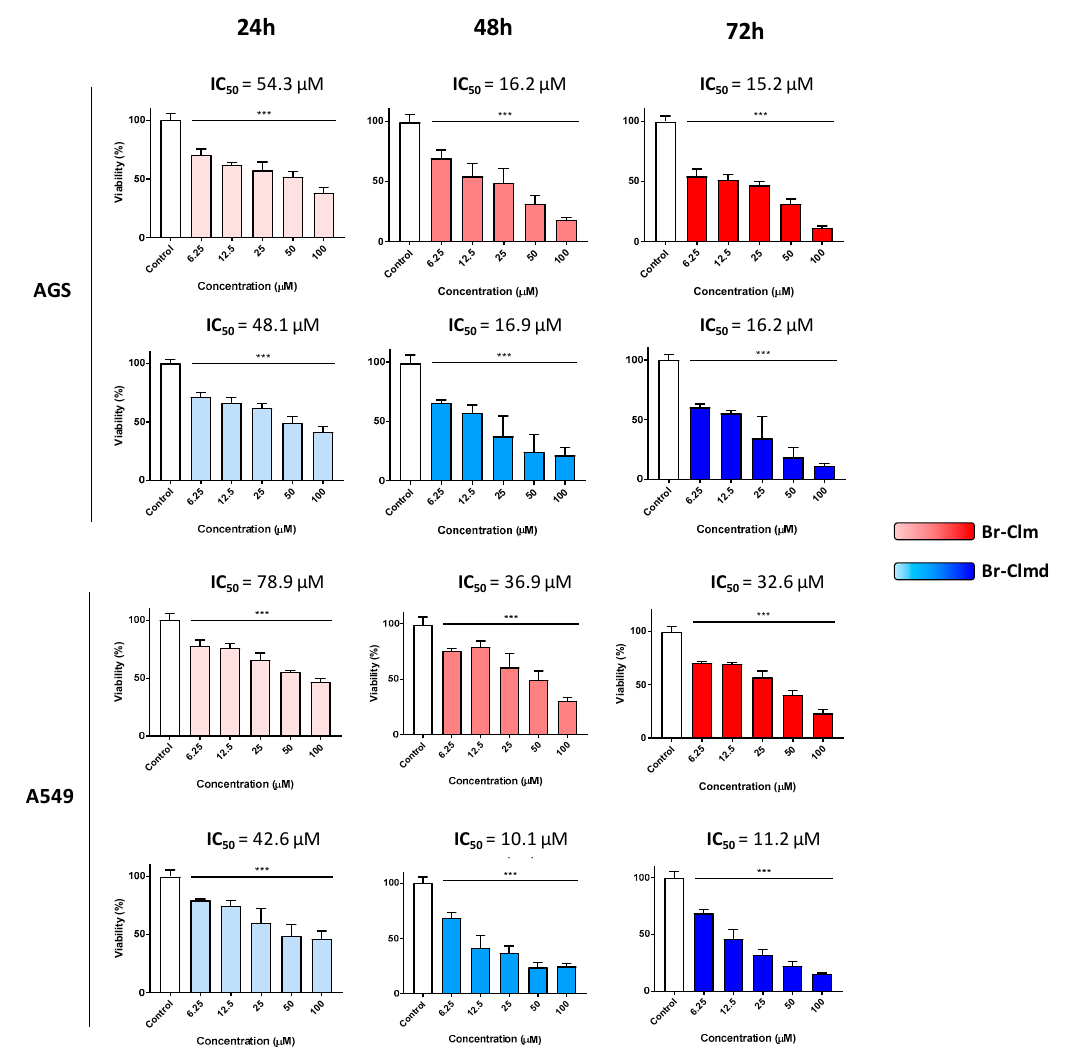
Figure 3. Viability of AGS and A549 cells exposed to Br-Clm (red) or Br-Clmd (blue) in the 6.25–100 µ M range for 24, 48, and 72 h. Statistical analysis was conducted between each treatment and the control. *** p < 0.001.